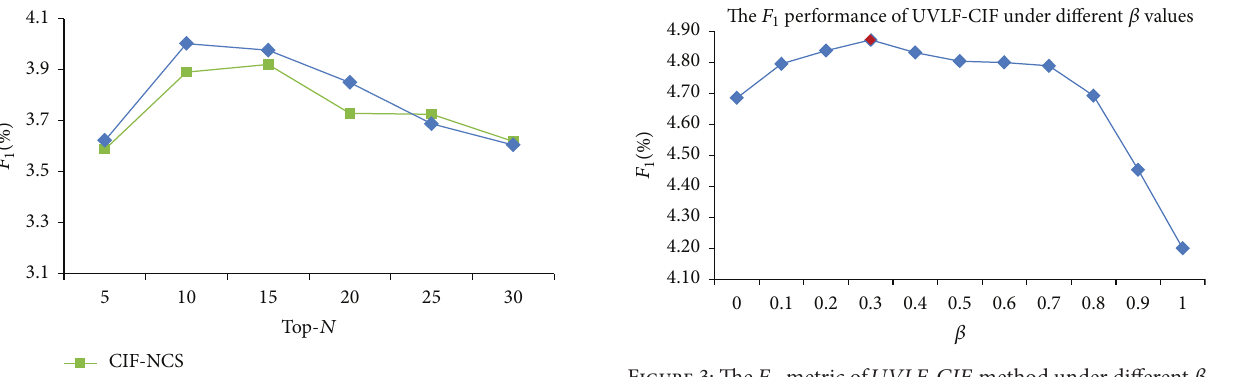
Figure 3: The 𝐹 1 -metric of 𝑈𝑉𝐿𝐹 - 𝐶𝐼𝐹 method under different 𝛽 .